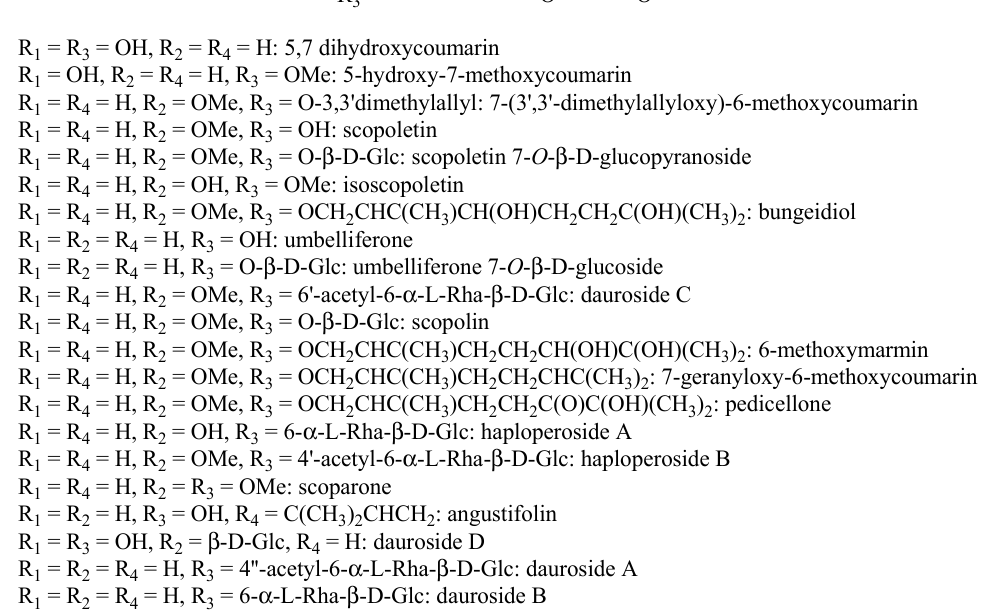
Figure 4. Structure of the coumarins identified in Haplophyllum species—part 2.